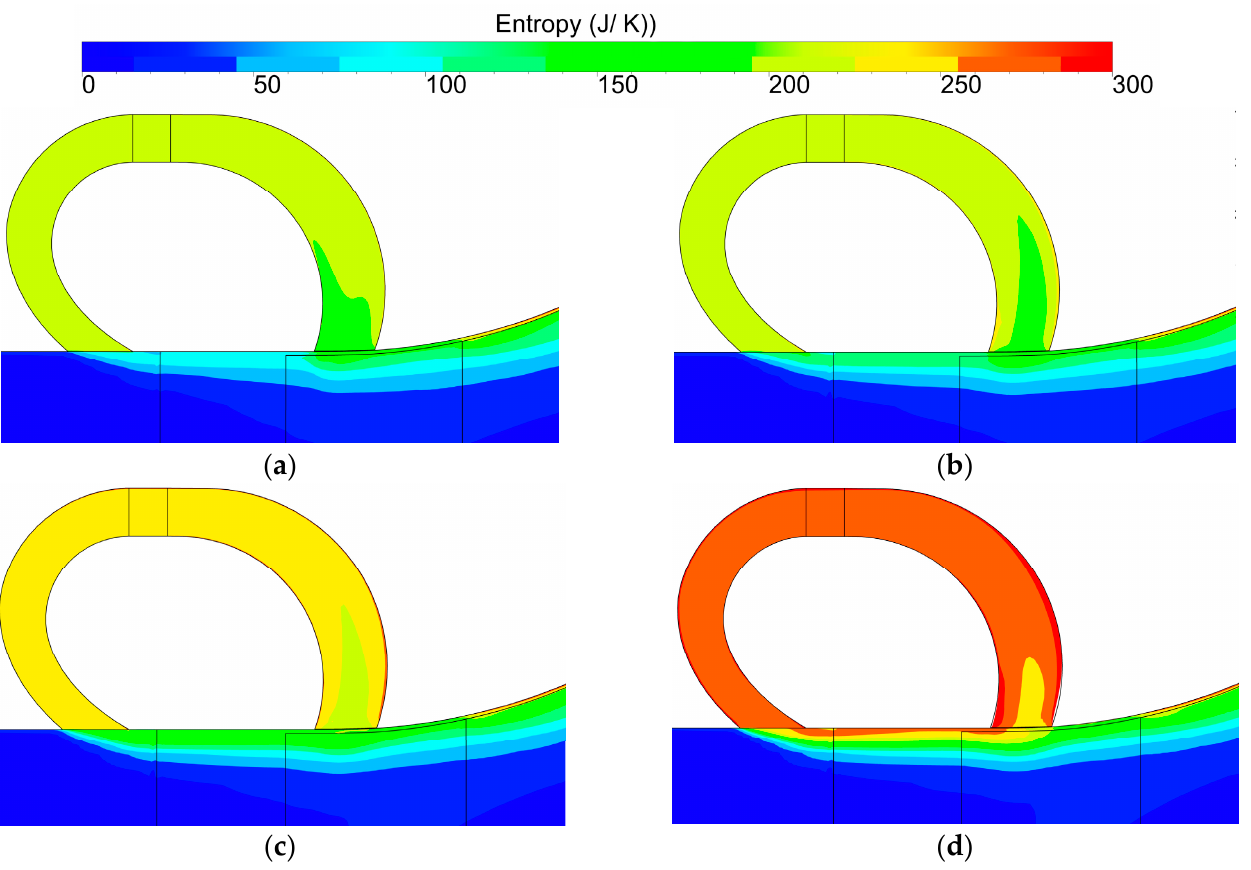
Figure 26. Contours distribution of entropy on the meridian plane under different self-circulating casings. ( a ) SW. ( b ) SRCC0.36. ( c ) SRCC0.54. ( d ) SRCC0.72. ( e ) SRCC0.9.